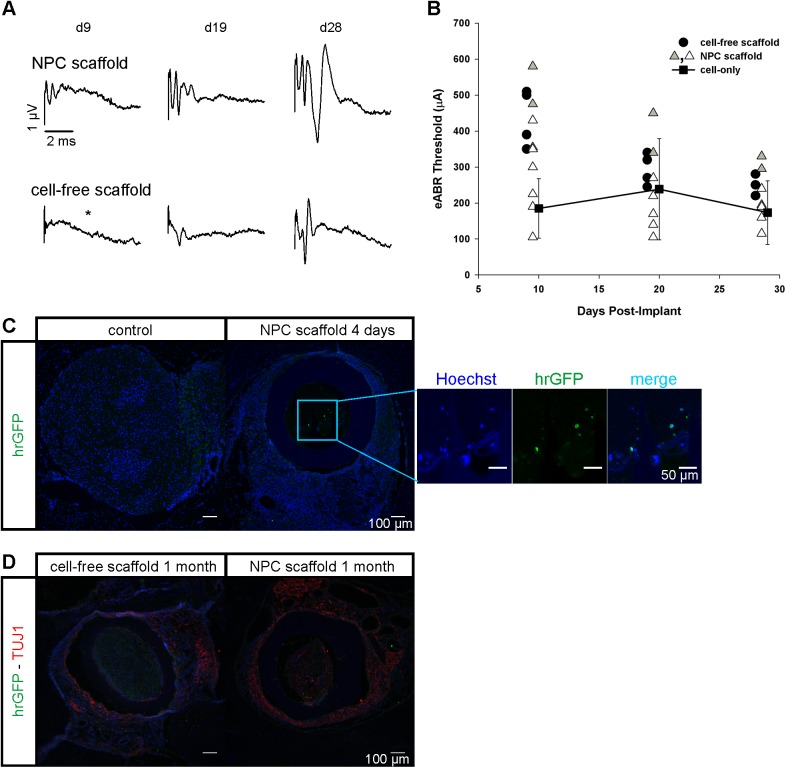
Post-implant physiology and histological assessment of H9-GFP derived NPC survival.(A) Representative examples of in vivo threshold eABR waveforms of cell-free and NPC scaffolds at post implantation days indicated. In both groups, waveforms are flattened after deafening and implantation. Profiles of distinct waves partially recover over the one month observation period. All responses were evoked with a 300 μA stimulus, except for the day-9 time point of the cell-free scaffold subject (indicated by *, 300 μA was below threshold and thus a 370 μA response is shown for illustration). (B) Course of post implantation eABR thresholds for individual animals implanted with cell-free scaffolds (n = 4) and NPC scaffolds (n = 9) is shown alongside the mean thresholds for NPC-only injections (n = 3). Gray triangle symbols indicate two animals implanted with dye-labeled NPC-scaffolds; the elevated thresholds in these animals may indicate a negative impact from the FluoroRuby dye on NPC health. Data points are slightly shifted in time for clarity. (C) hrGFP immunohistochemistry for the detection of H9-GFP derived NPCs in sections of control and implanted specimen collected 4 days post implantation. The excerpt shows a magnification of the interior of the scaffold with hrGFP expression in two Hoechst-positive cells (blue channel enhanced for illustration). (D) There was no hrGFP signal detected in 1 month implantations. TUJ1 stain shows interspersed fibers both in cell-free and NPC-seeded conditions. Scale bars represent 100 μm in C and D and 50 μm in the excerpt of C.